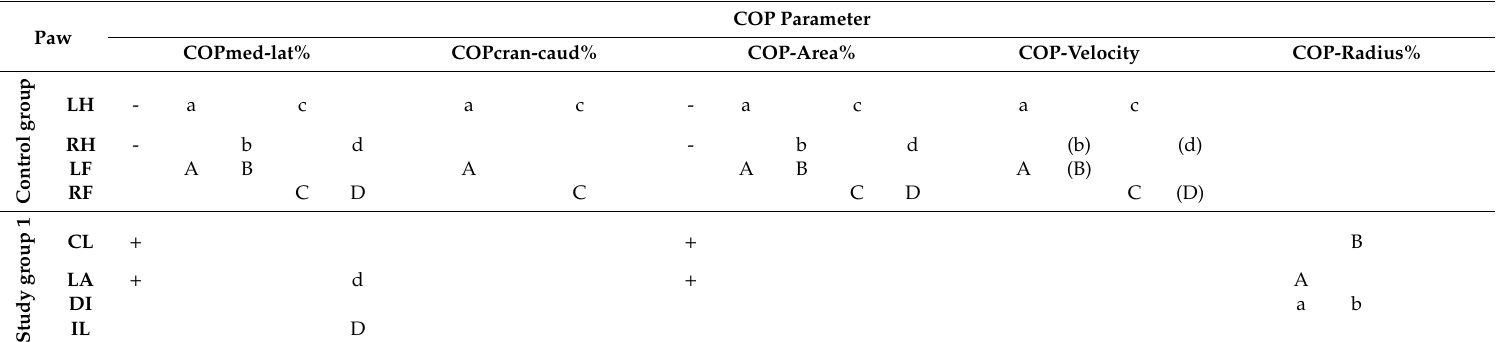
Table 1. Overview of the significant di ff erences in the COP parameters of study group 1 and control